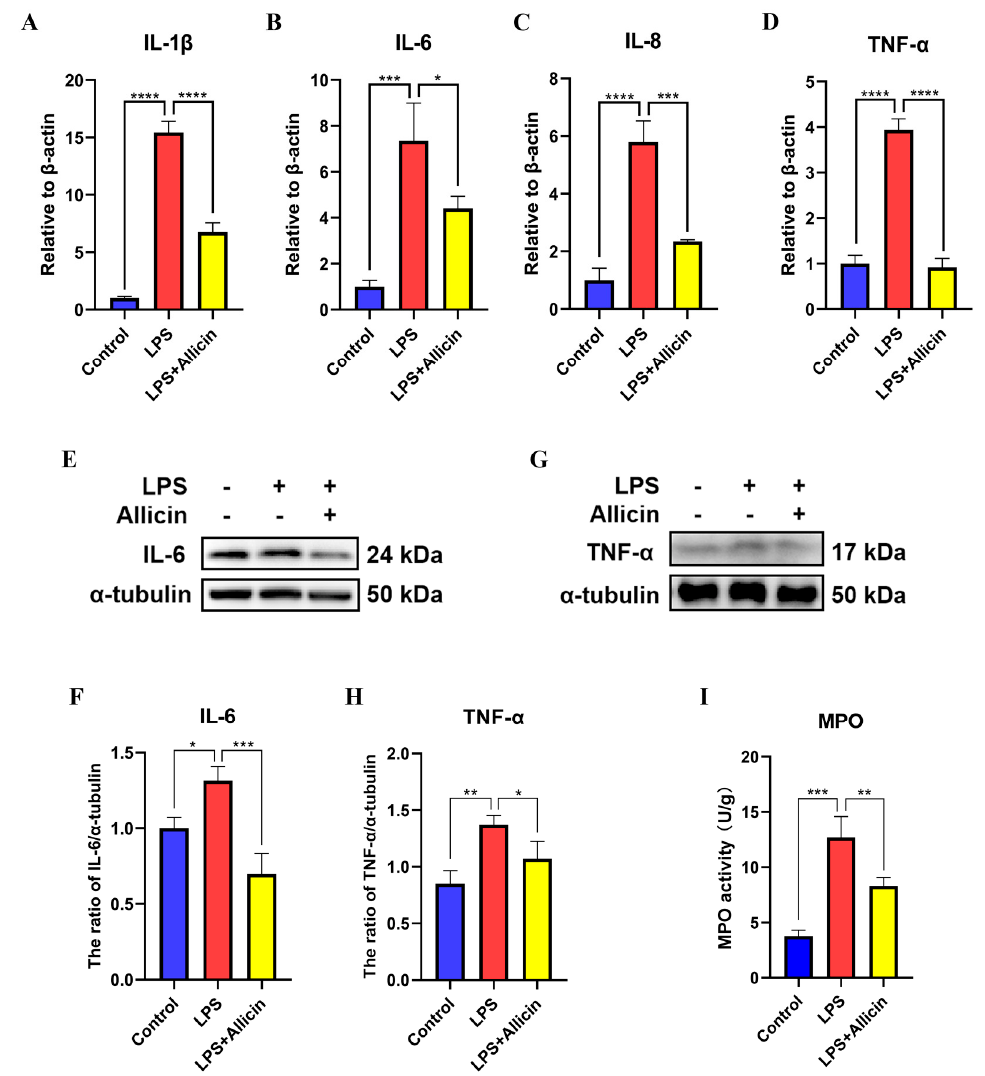
Figure 6. Effect of allicin on the expression of inflammatory cytokine genes in breast tissues. ( A – D ) mRNA expression levels of IL-1 β , IL-6, IL-8, and TNF- α in breast tissues were detected using RT–qPCR with β -actin used as an endogenous control. ( E – H ) The protein expression levels of IL-6 and TNF- α in breast tissues were detected using Western blotting, and α -tubulin was used as a control. ( I ) Mammary gland MPO activity assay. *, p < 0.05; **, p < 0.01; ***, p < 0.001; ****, p < 0.0001.